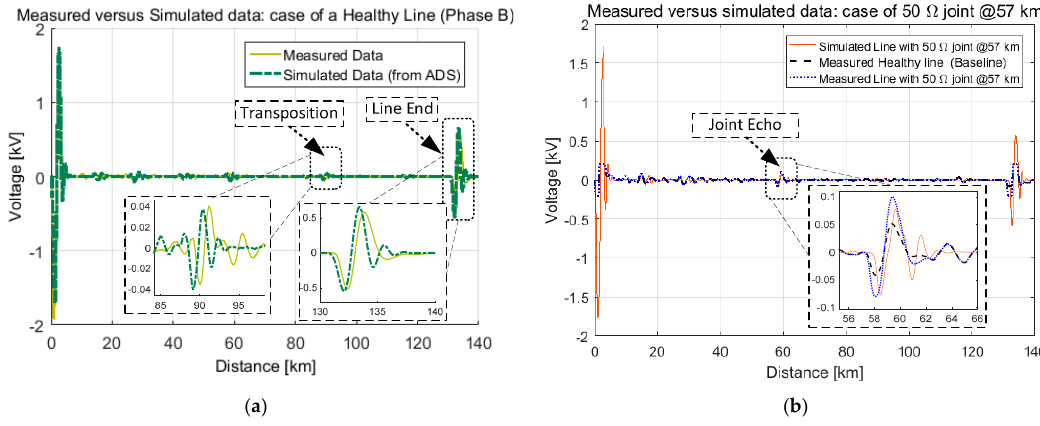
Figure 2. Agreement between the simulation study results and real measurements for the cases of: ( a ) healthy line, ( b ) line including an artificial impedance variation at the 57th km.